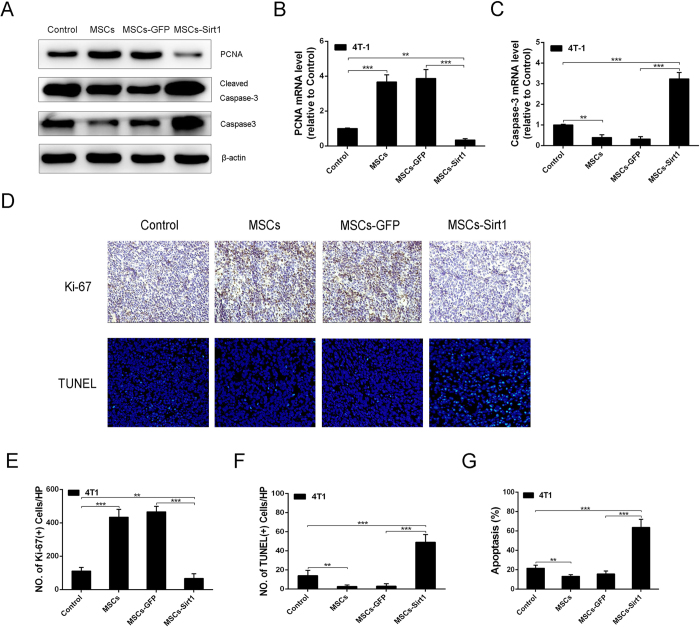
The effect of Sirt1 overexpressed MSCs on 4T1 cells prolifeation and apoptosis in vivo.(A) Western blotting was employed to examine the PCNA, Caspase-3 and Cleaved Caspase-3 protein expression levels of tumors. Real-time PCR was employed to examine the PCNA (B) and Caspase-3 (C) expression levels of tumors. Results were reported as ratio to control group. (D) 4T1 tumor tissues were analyzed for immunohistochemical staining of Ki-67. Apoptosis of 4T1 tumor tissues were determined by TUNEL assay. Typical photographs were presented (original magnification: × 200). (E) The number of Ki-67-positive cells per HP (mean ± SD) was quantified from each group. (F) The quantification of TUNEL-positive tumor cells was shown as mean ± SD. (G) The apoptosis was analyzed by flow cytometry using Annexin V-FITC/PI and data were shown as mean ± SD. HP, high power field (400 × ). **, P < 0.01; ***, P < 0.001.